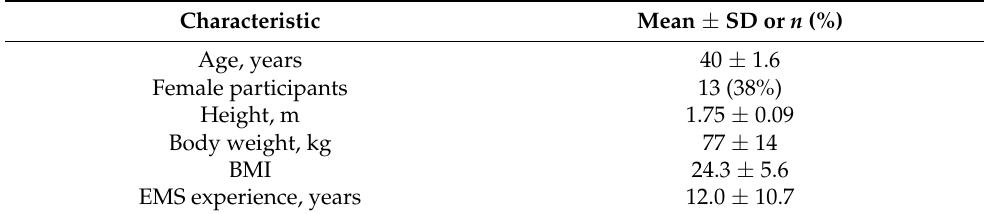
Table 1. Baseline characteristics of the study